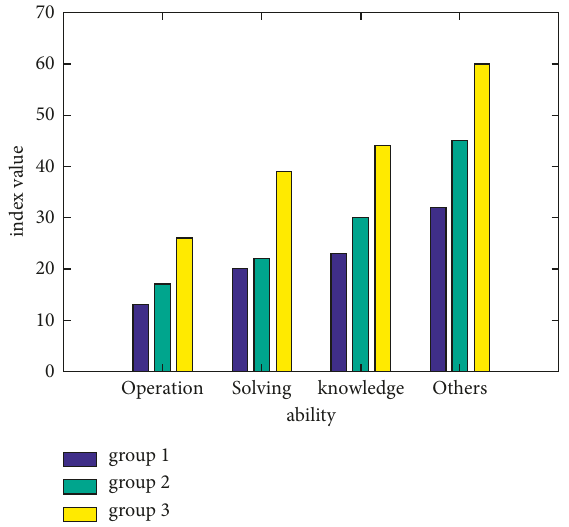
Figure 6: Results based on quantitative evaluation